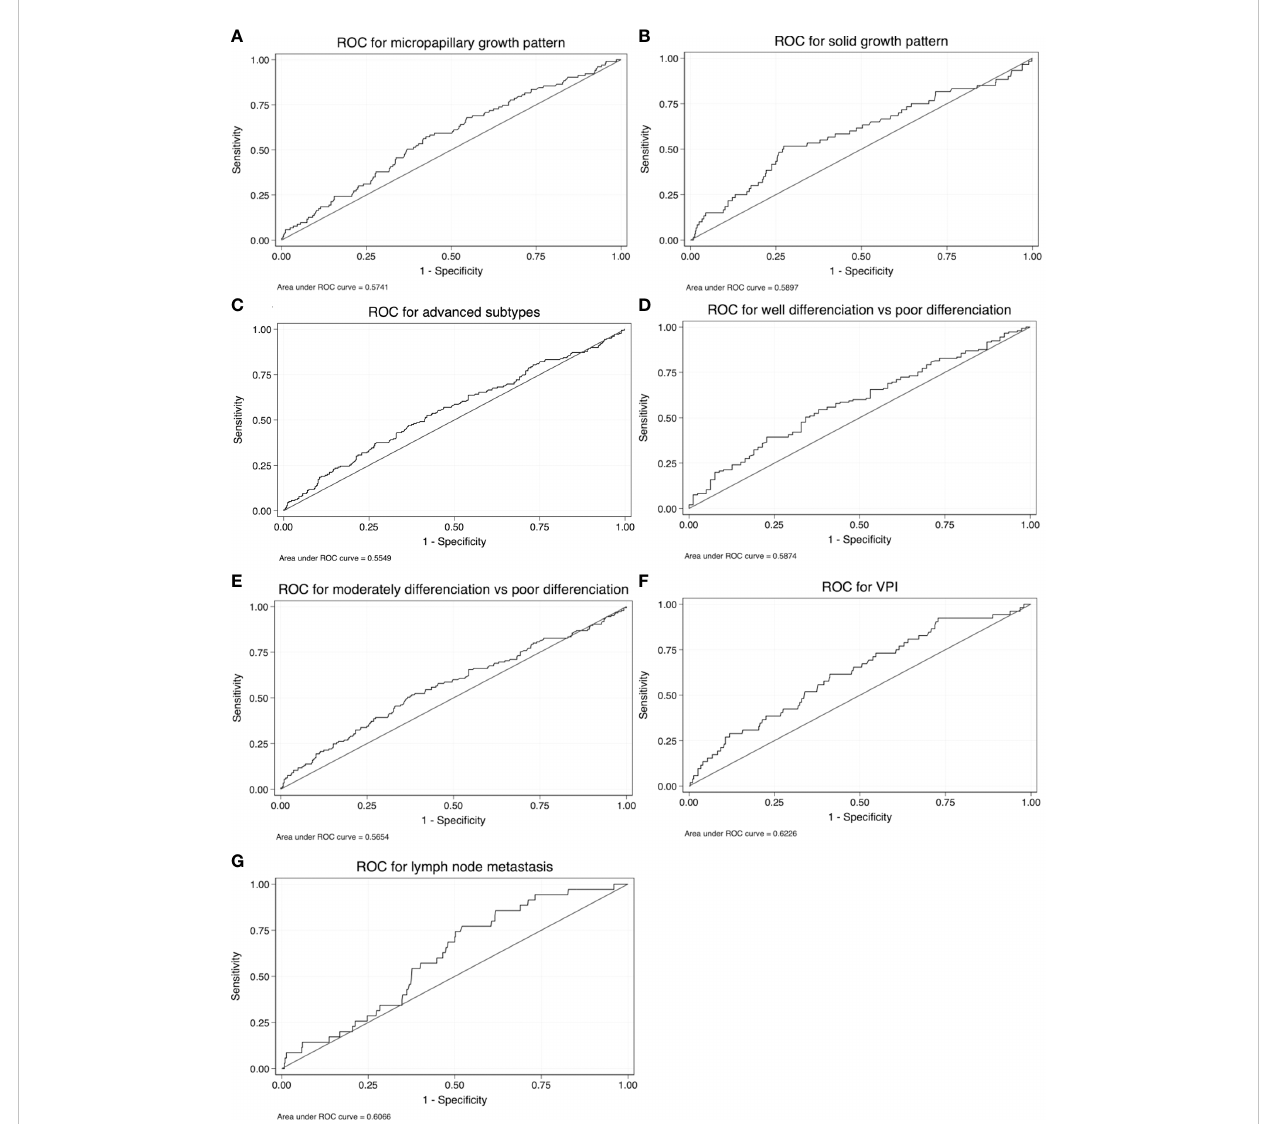
FIGURE 5 Receiver operating characteristic (ROC) curves for FR + CTC level as a test for (A) micropapillary components, (B) solid components, (C) advanced subtypes, (D) well-differentiated vs . poorly differentiated tumors, (E) moderately differentiated vs . poorly differentiated tumors, (F) VPI, and (G) lymph node